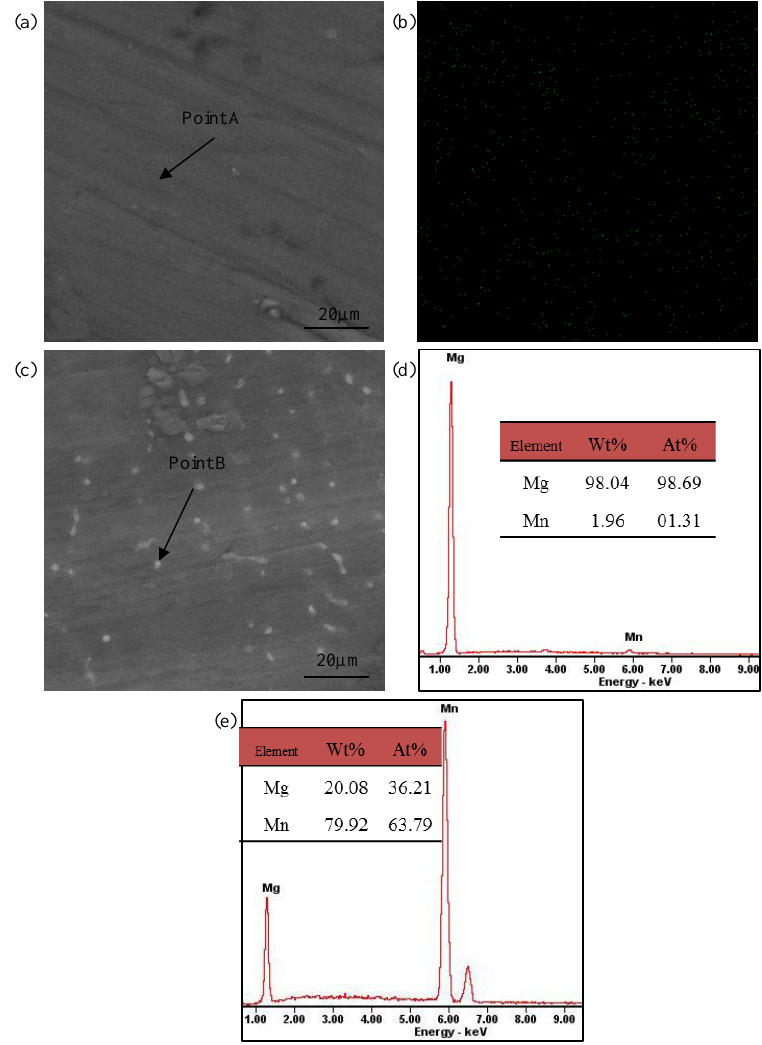
Figure 3. ( a ) BSE image of Mg-2Mn alloy; ( b ) EDS map of Mn element in Mg-2Mn alloy; ( c ) BSE image of Mg-3Mn alloy; ( d ) Corresponding point EDS analysis marked by arrow A in Figure 3a; ( e ) Corresponding point EDS analysis of bright grain marked by arrow B in Figure 3c.